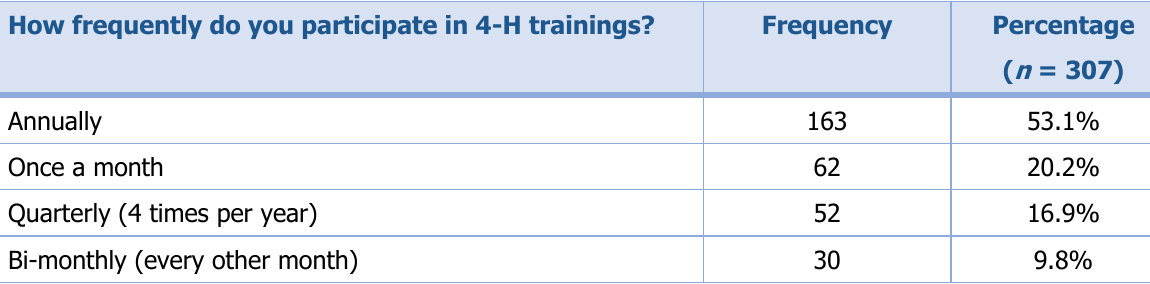
Table 1. Frequency of Participation in 4-H